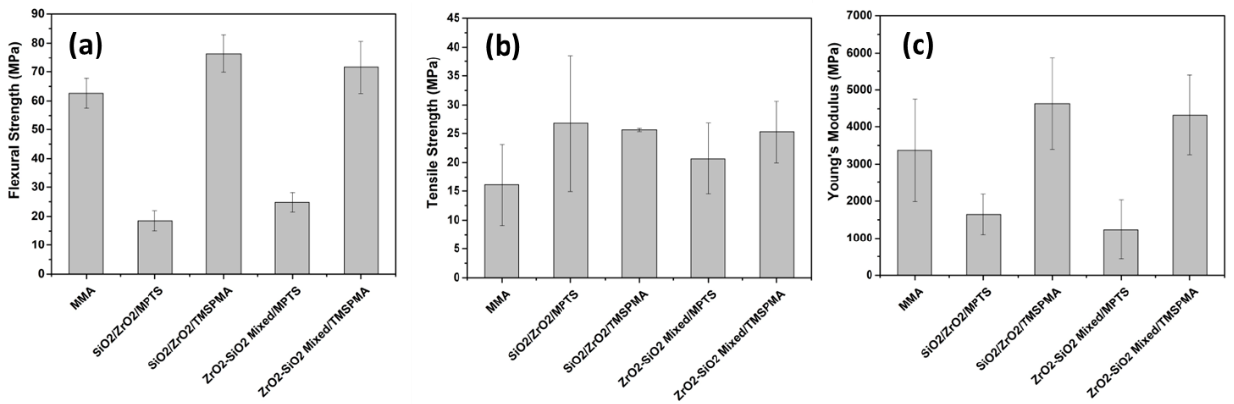
Figure 10. ( a ) Flexural, ( b ) DTS, and ( c ) Modulus of Elasticity. The SiO 2 /ZrO 2 /TMSPMA sample has a higher flexural value and a reasonably large DTS value than the other samples. In contrast, the SiO 2 /ZrO 2 /TMSPMA composite pro-